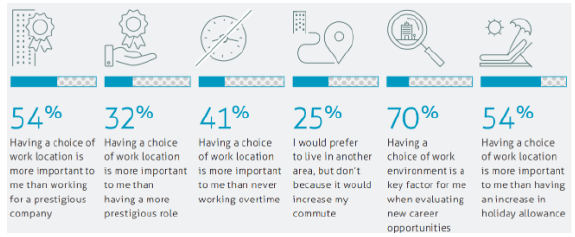
Fig 4. Importance of saving commuting time to invest in other daily